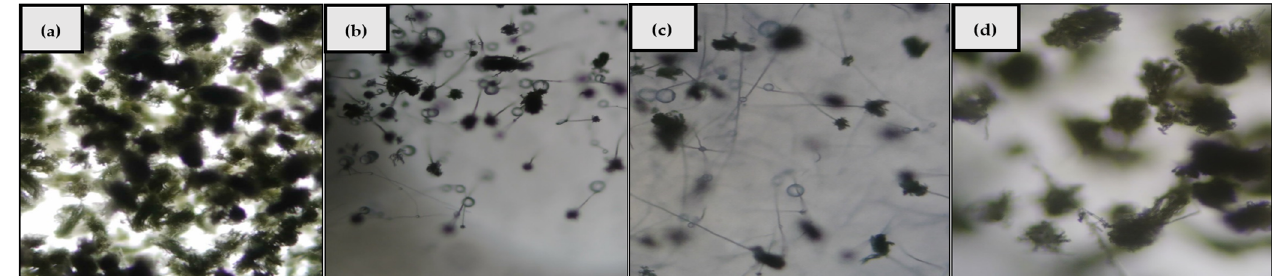
Figure 5. Microscopic observation of antifungal activity of the treatment of ( a ) control ( Aspergillus flavus ); ( b ) positive control (ketoconazole); ( c ) Pichia norvegensis NYI; ( d ) β -glucan. Table 3. Aflatoxin-reducing activity of Pichia orvegensis NYI and its β -glucan.